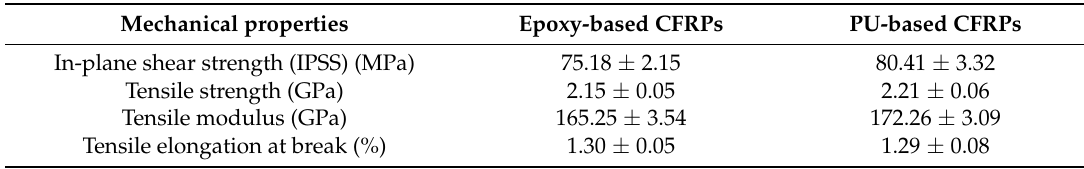
Table 1. Mechanical properties of epoxy- and polyurethane (PU)-based carbon fiber reinforced polymers